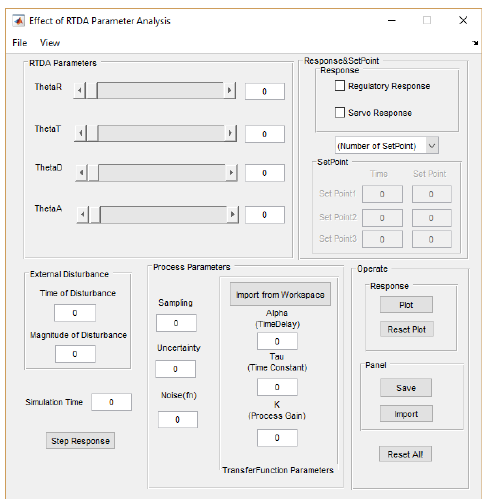
Figure 5. GUI for analyzing the effect of the RTD-A parameter. Algorithms 2019 , 12 , x FOR PEER REVIEW